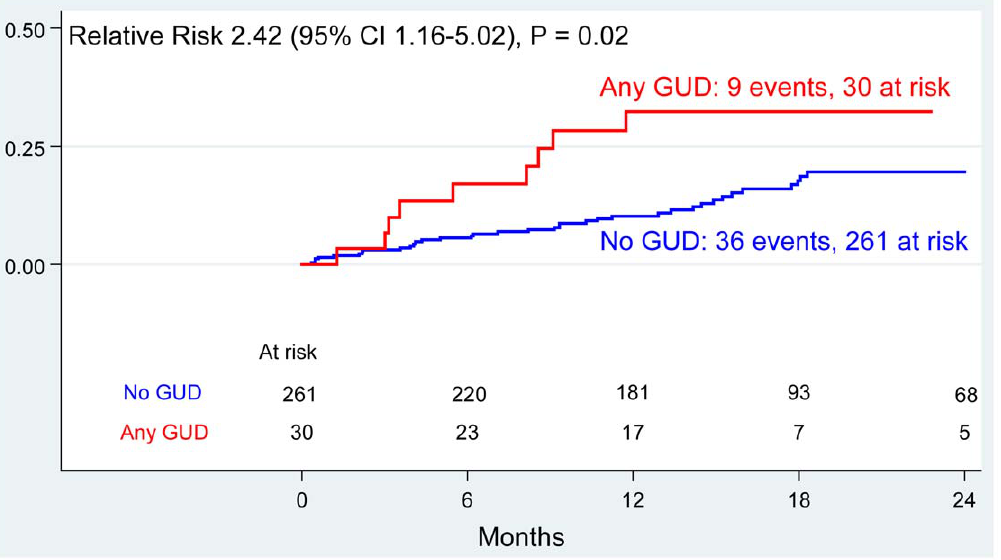
Figure 3. Risk of Opportunistic Infection, by GUD (Kaplan-Meier Estimates). Opportunistic infection is defined as: first episode of herpes zoster, Pneumocystis jirovecii pneumonia, tuberculosis, Kaposi sarcoma, meningitis, or encephalitis. Relative risk calculated using Cox regression. Time=months since delivery.